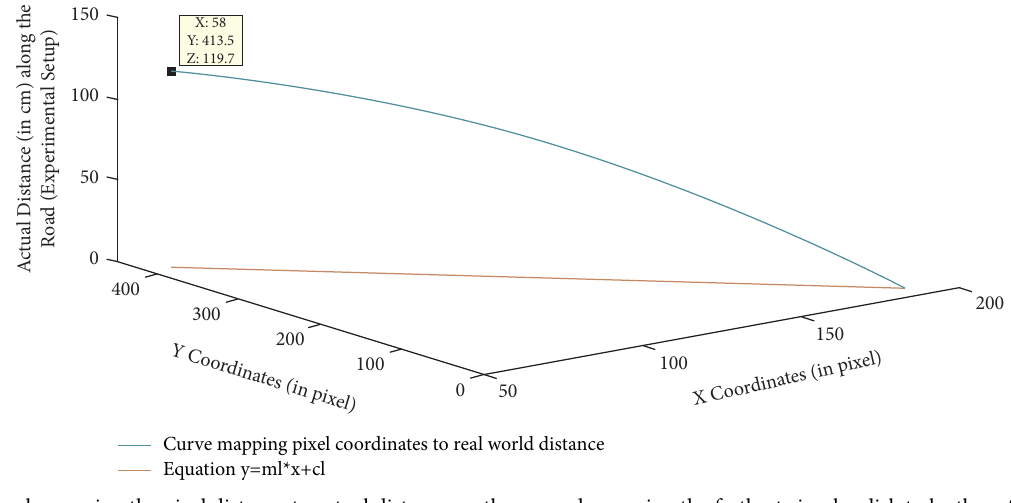
Figure 9: Graph mapping the pixel distance to actual distance on the ground assuming the farthest circular disk to be the reference point.